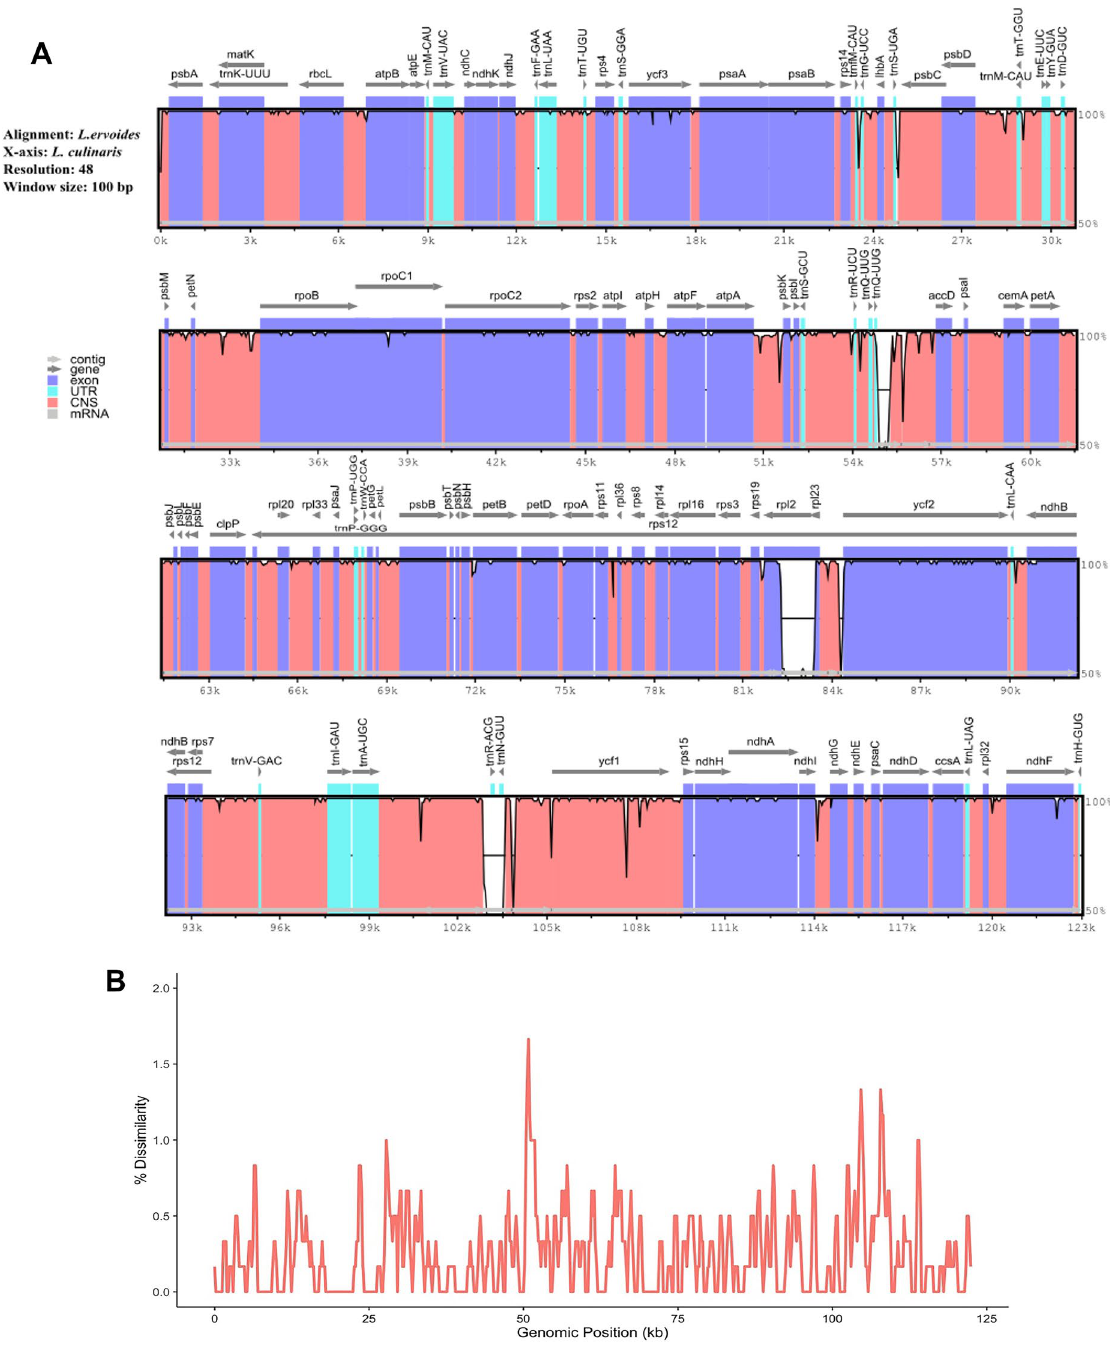
Figure 3. ( A ) mVISTA analysis of two cp genomes. Grey arrows show the direction of gene translation. The y-axis gives percent identity ranging from 50–100% and exon, conserved noncoding sequence (CNS), tRNAs, tRNAs are represented in different colours. ( B ) Percent dissimilarity (mismatches) between L. ervoides and L. culinaris throughout their cp genomes with 1 kb window and 200 bp sliding step. Repetitive regions determined by miropeats are